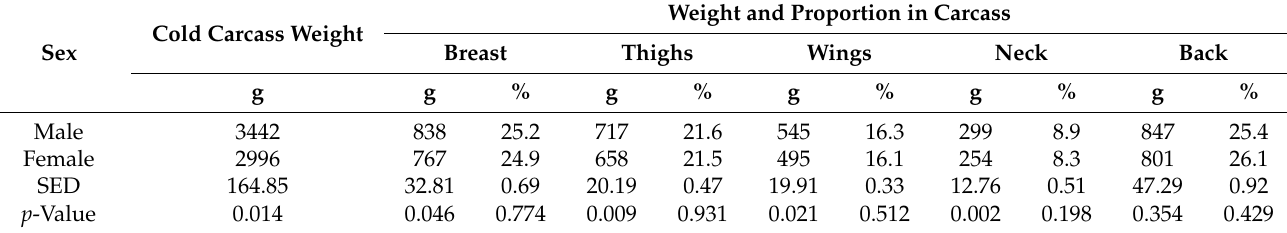
Table 3. Carcass composition of Vištin˙es